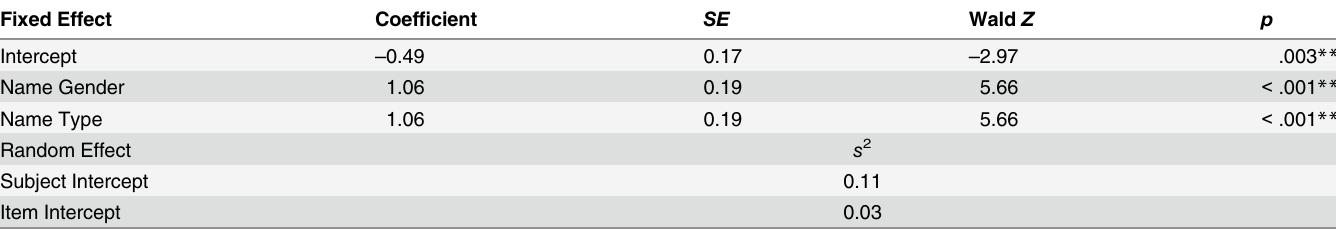
Table 3. Summary of logistic regression predicting the likelihood of a round silhouette selection.